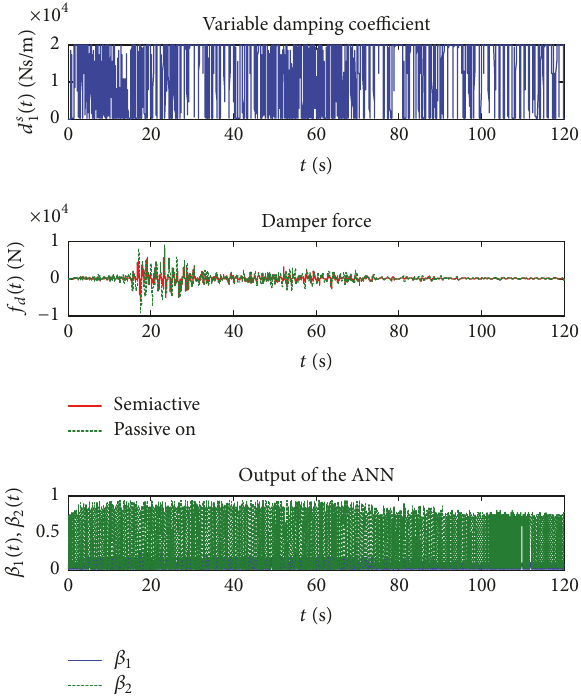
Figure 24: Simulation results for the Akita NS (1983) earthquake disturbance; variable damping coefficient 𝑑 𝑠 1 (𝑡) , force of damper 𝑓 (𝑡) , and output signals of the ANN 𝛽 𝑑